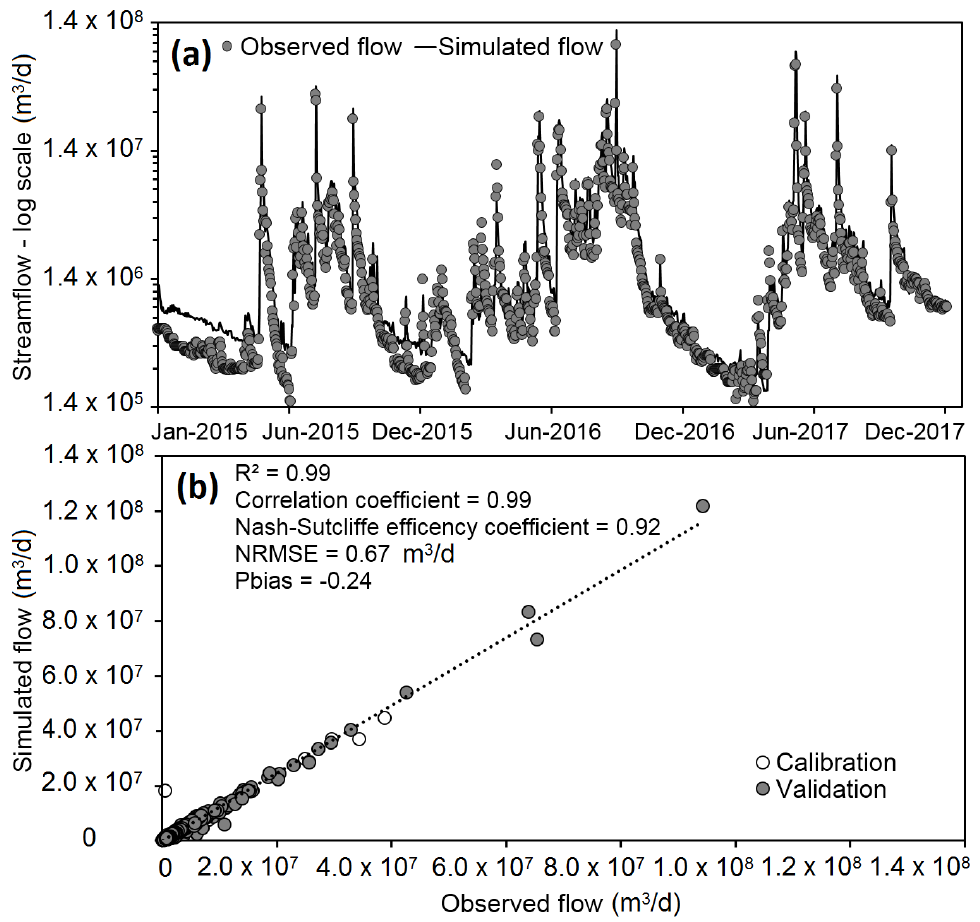
Figure 8. The comparison of the observed and simulated streamflow at Li-lin Bridge station in the PPGB: ( a ) the variations of stream discharge rates in logarithmic scale, and ( b ) the scatterplot of simulated and observed stream discharge rates and the associated performance statistics for the model.